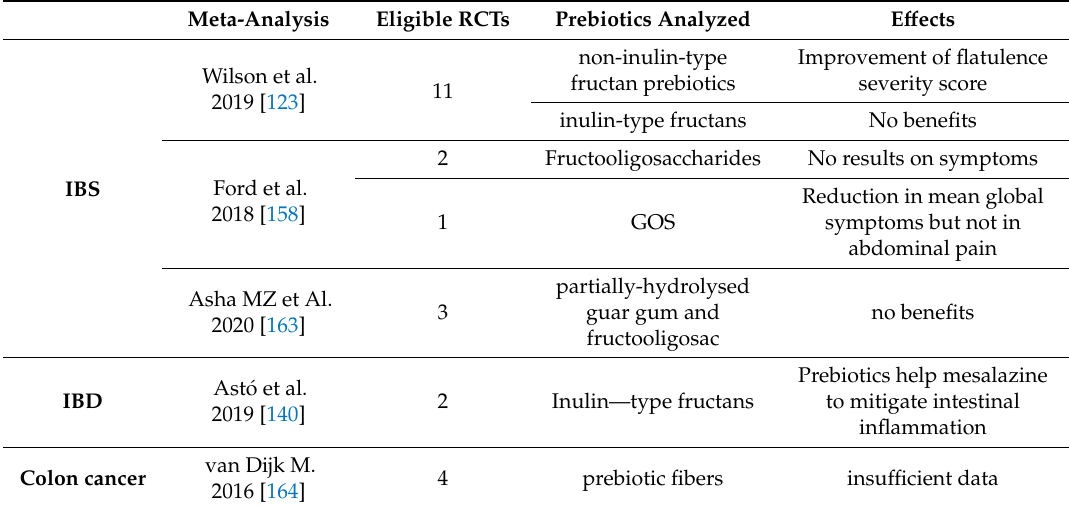
Table 3. Summary of most relevant meta-analysis results of prebiotics’ e ff ects in irritable bowel syndrome (IBS), inflammatory bowel diseases (IBD) and colon